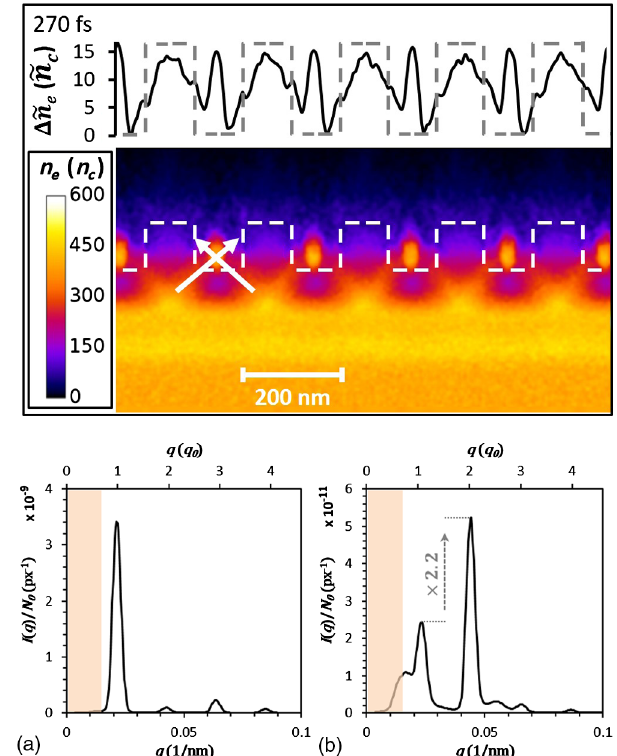
FIG. 4. Transient plasma grating. Top: Particle-in-cell simulated ¼ 1 . 7 × 10 21 cm − 3 ) suggest the electron densities (in units of n c emission of plasma jets (white arrows) from the sharp edges at the surface. Integrating along the vertical direction (top panel), we find the grating frequency doubled. Bottom: Cuts through the exper- imental scattering pattern for an XFEL-only preshot (a) and main shot with HI laser energy 400 mJ and delay 6 ps (b). In the main shot we observe the intensity of the second peak being larger than that of the first peak, being forbidden for a single grating with grating vector q 0 . See Supplemental Material for details